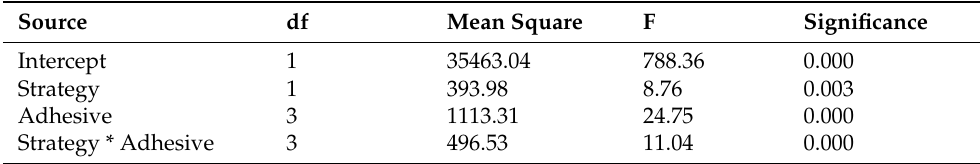
Table 7. Tests for type III fixed effects (LMM) of nanoleakage data. Source df